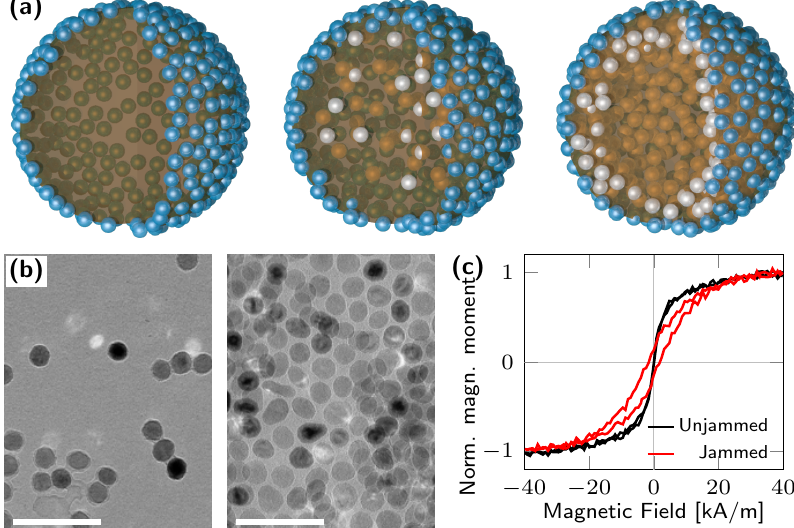
Figure 2. Jamming of superparamagnetic nanoparticles at liquid–liquid interfaces. ( a ) Schematics of ferromagnetic liquid droplets structured by jammed nanoparticles (blue spheres) without and with dispersed nanoparticles (gray spheres), and with nanoparticle surfactants forming multilayers (gray spheres). ( b ) Structural short-range order of unjammed and jammed superparamagnetic nanoparticles visualized with transmission electron microscopy. Scale bar is 100 nm. ( c ) Magnetic hysteresis loops of jammed (ferromagnetic) and unjammed (paramagnetic) liquid droplets obtained by vibrating sample